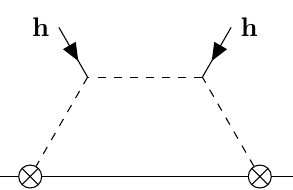
Figure 11 . 1-loop Feynman diagram in the bulk-defect system whose BRST variation necessitates corrections to the w, w OPEs. Dotted lines designate η propagators, and crossed dots represent couplings of η to the e, f